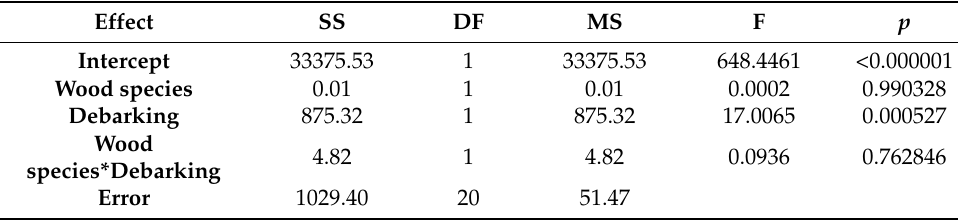
Table A3. ANOVA table for the moisture